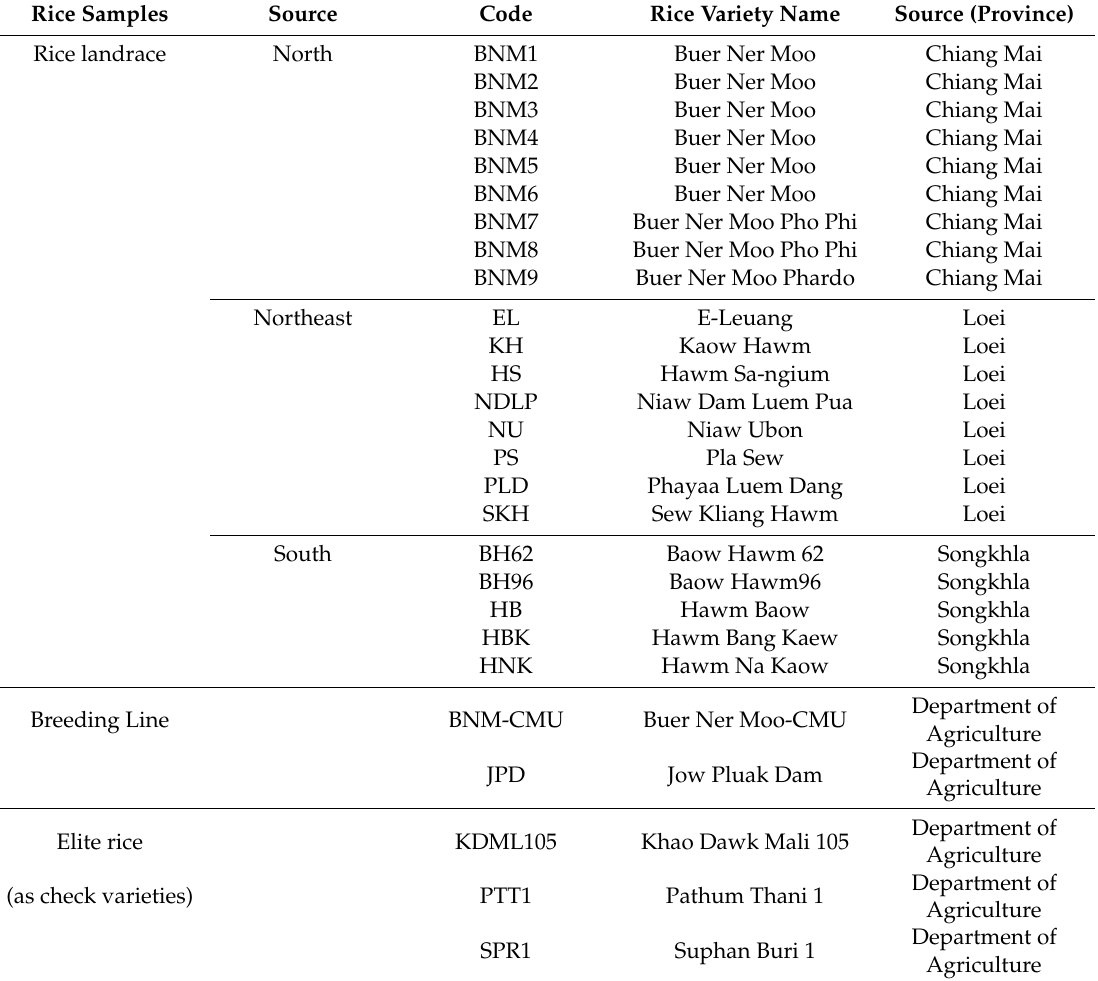
Table 1. List of the fragrant rice landraces from three regions of Thailand, the elite varieties, and the advanced breeding lines studied for